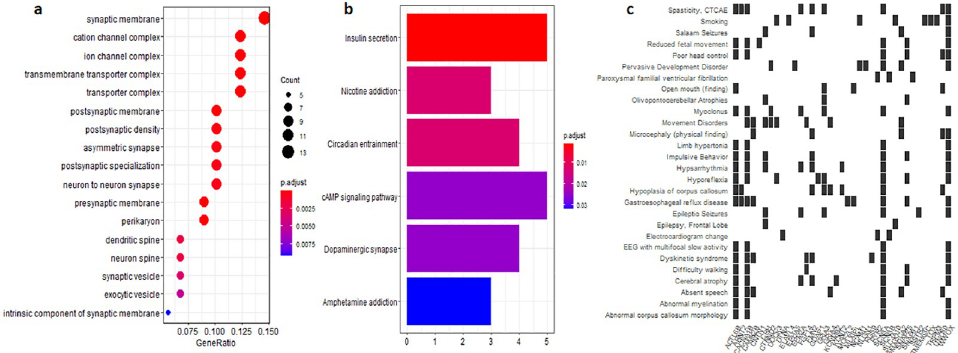
genes showed significant association with the OS of PDAC patients in cohort 1 and 2 ( S7 and S8 Tables in S1 File). Predominantly, the overexpression of CCDC30 , DSCAM , FMN2 , PGR , SCN3B , WDR17 , ZNF540 and ZSCAN18 from FGF14 -specific coexpressed genes showed sig- nificant association with good OS in cohort 1 and 2 ( S5 Fig in S1 File). Next the association of